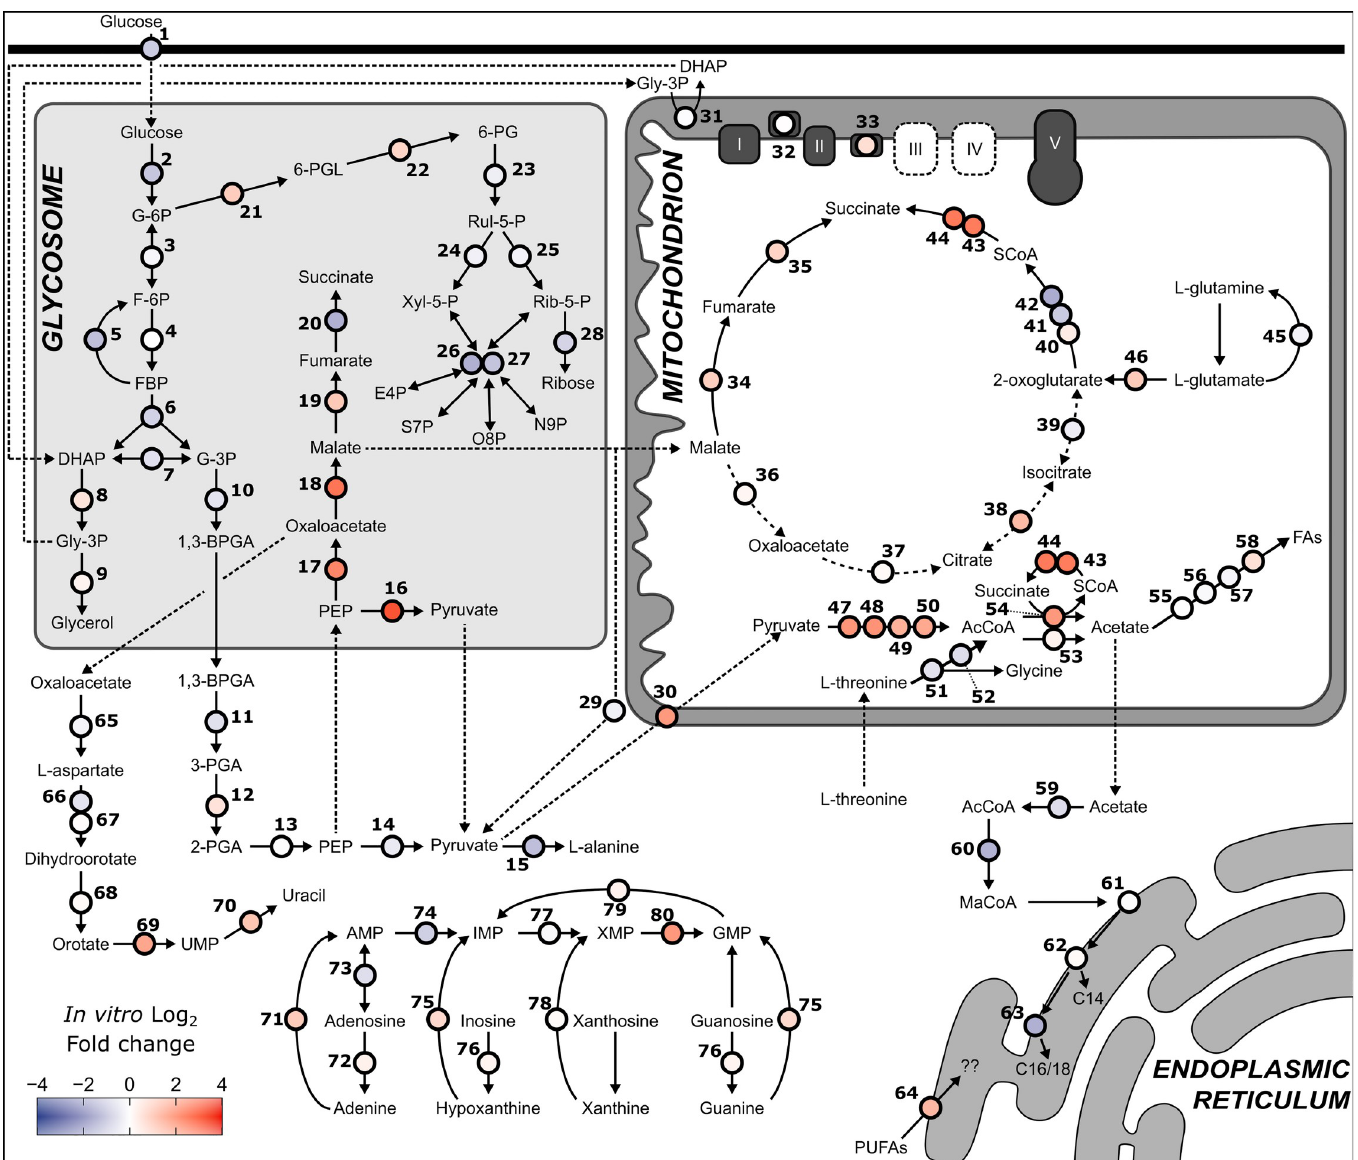
Fig 8. Summary of T . congolense and T . brucei in vitro transcriptome. Log 2 fold change ( T . congolense / T . brucei ) was calculated for each gene. Dashed lines represent transport processes. Genes: 1, hexose transporters, TbTc_0095; 2, hexokinase, TbTc_0341; 3, glucose-6-phosphate isomerase, TbTc_1840; 4,